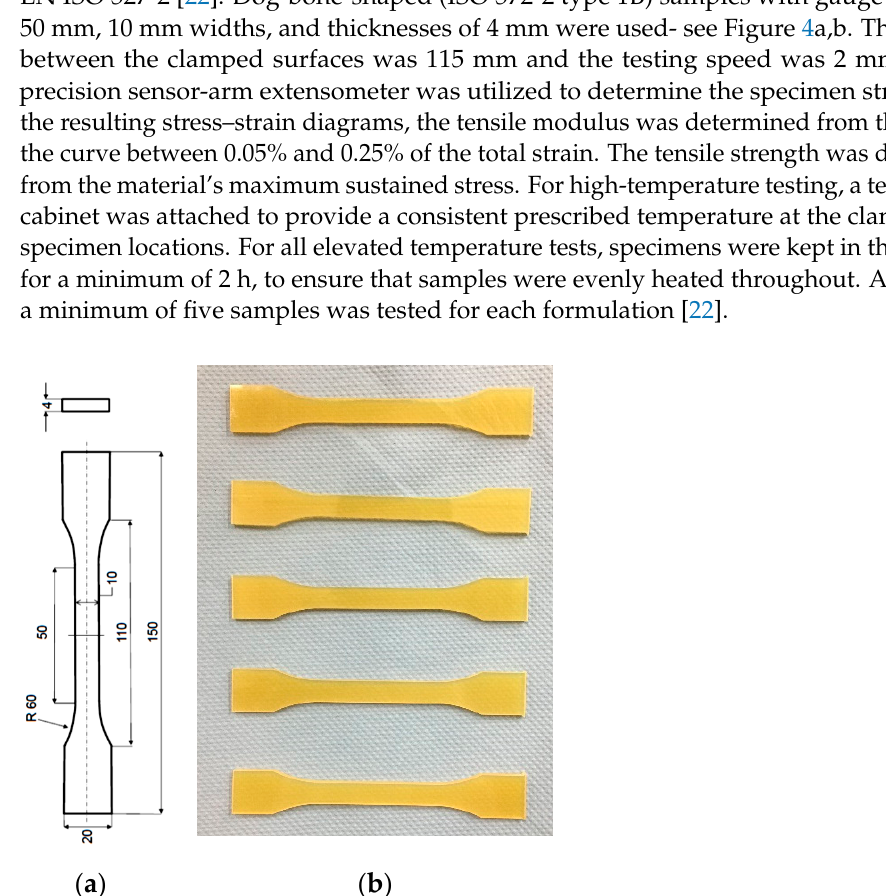
Figure 3. Schematic diagram of sample preparation.